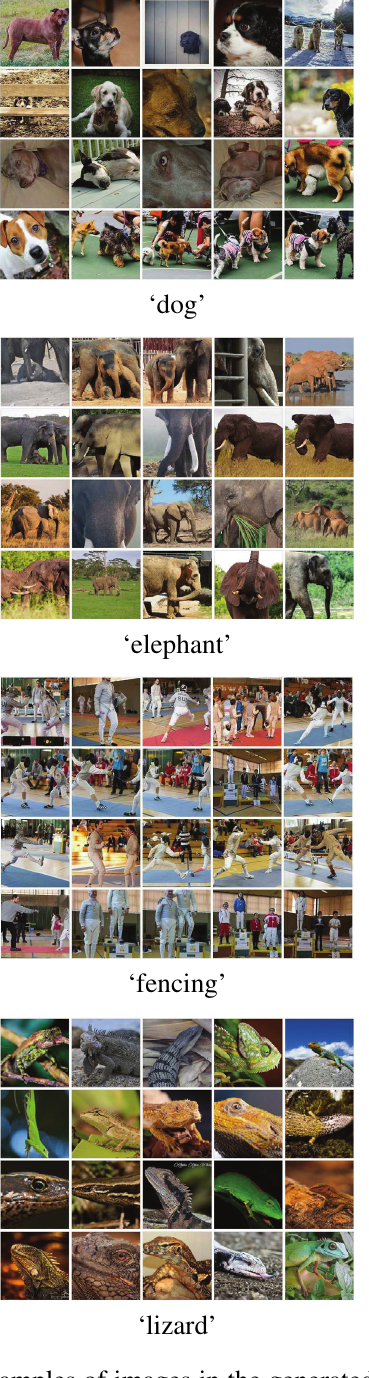
Figure 3: Examples of images in the generated database: images for ‘dog,’ ‘crab,’ ‘elephant,’ ‘man,’ ‘fencing,’ ‘army,’ ‘lizard’ and